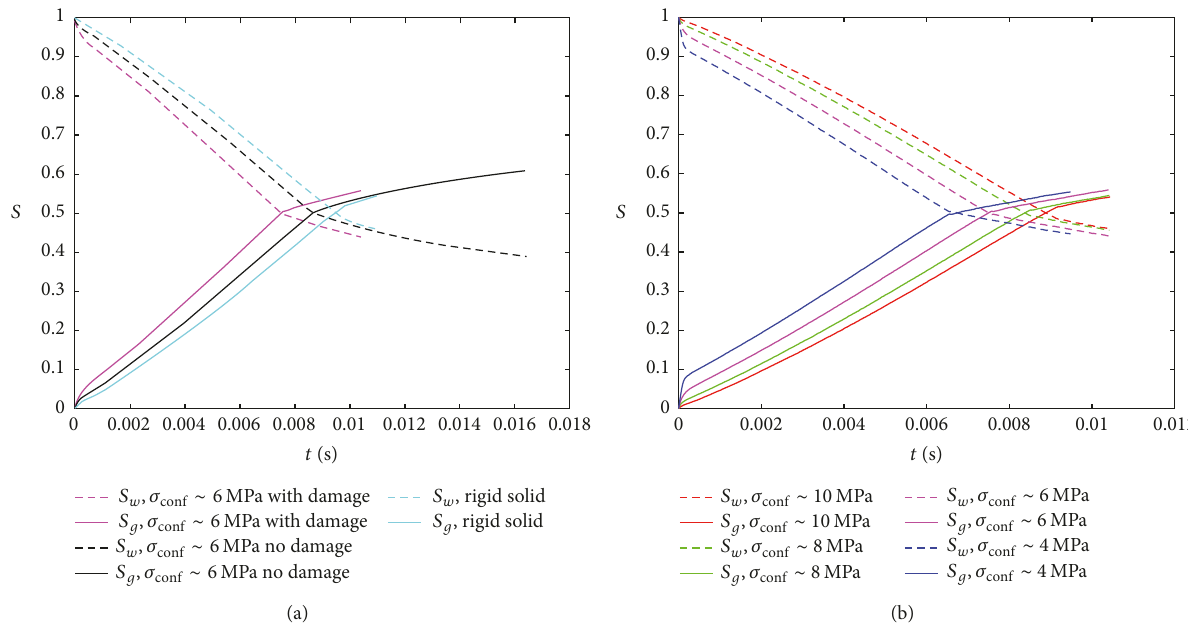
Figure 9: Liquid 𝑆 𝑤 (broken lines) and gas 𝑆 𝑔 (solid lines) saturations evolution for simulations varying from rigid matrix to confined elastic matrix with damage. (a) Rigid solid matrix (cyan) and elastic matrix under confining stress 𝜎 damage applied to the elastic phase. (b) Elastic matrix with application of damage model under confining stresses of 𝜎 𝜎 ∼8 MPa (green), 𝜎 ∼6 MPa (magenta), and 𝜎 ∼4 MPa conf conf conf